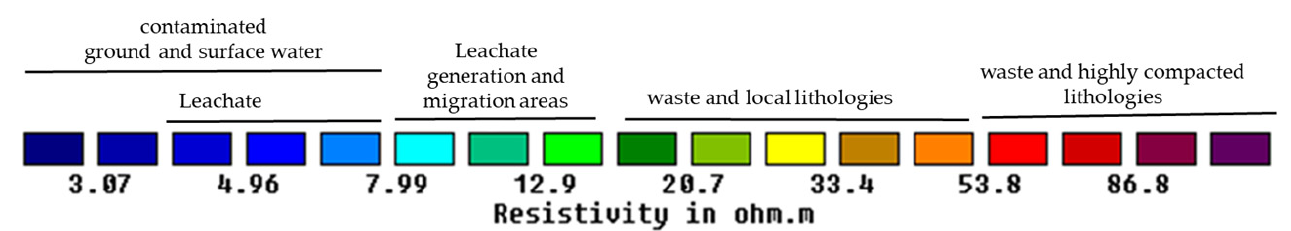
Figure 4. Calibrated color scale showing the resistivity range of materials and their characteristics.